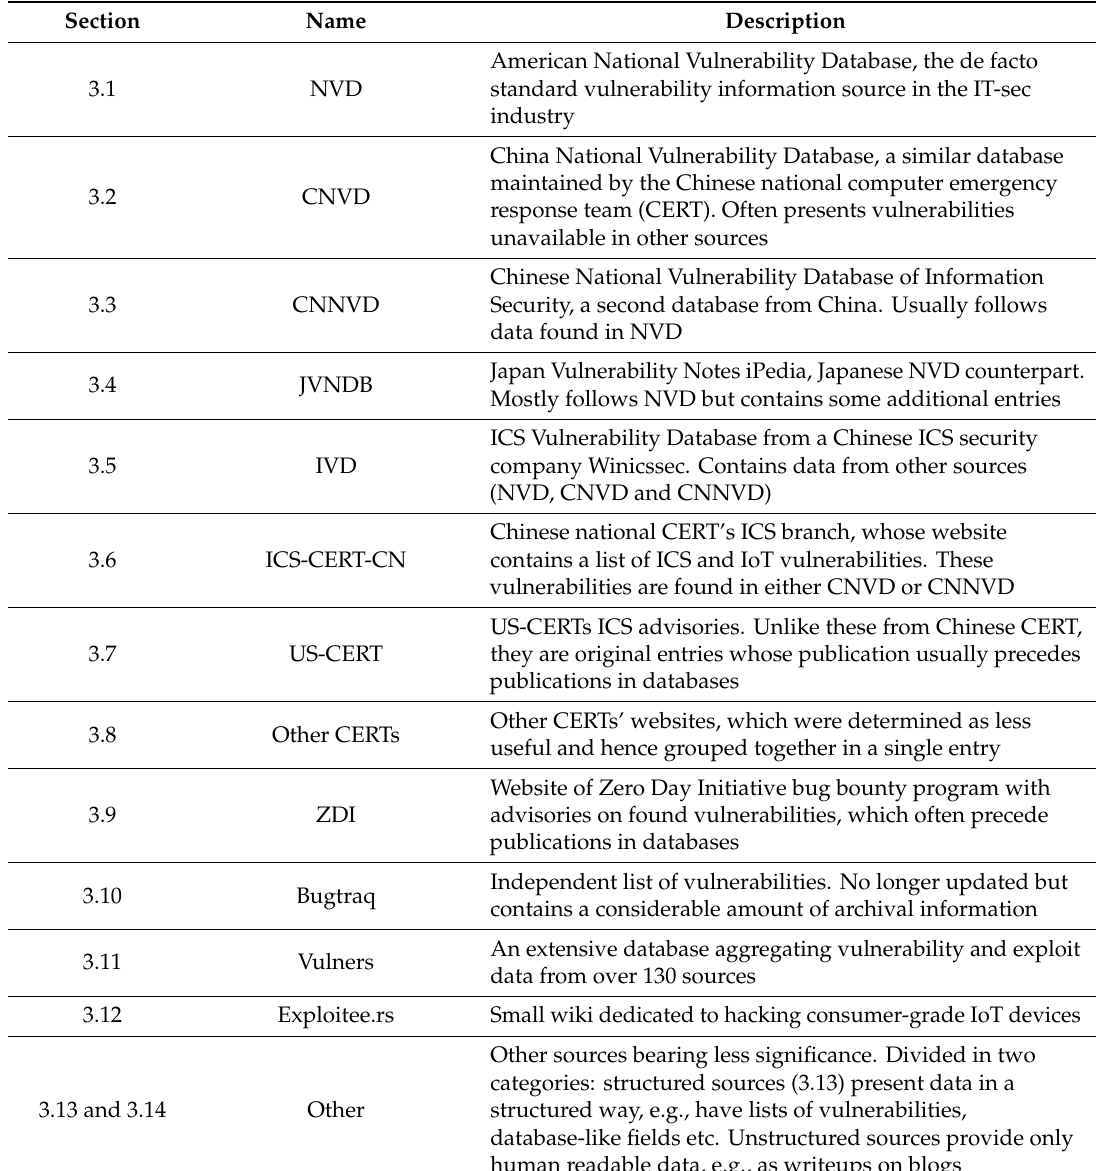
Table 1. A short overview of the sources discussed in this